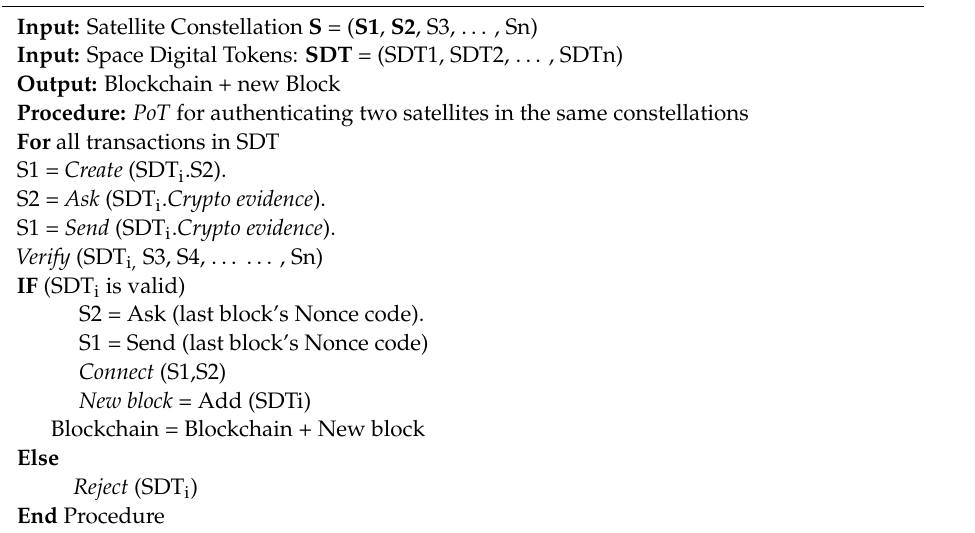
Algorithm 1: PoST for authenticating two satellites in the same constellations